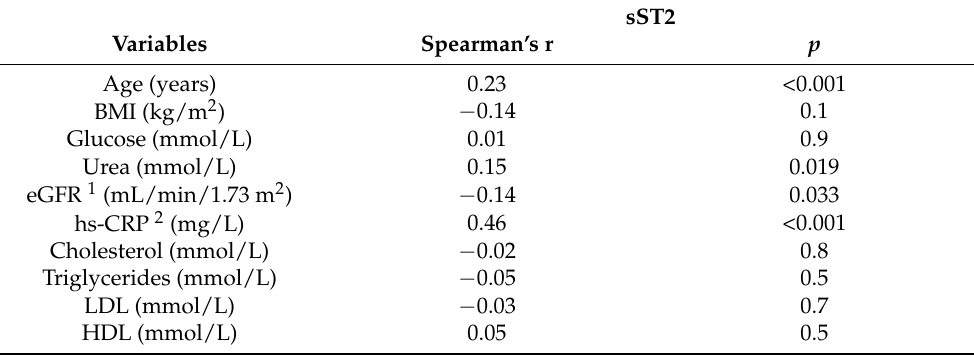
Table 3. Univariate correlates of continuous variables and sST2